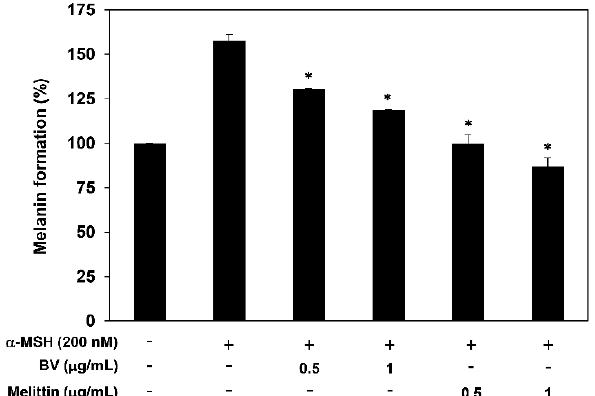
Figure 5. The effect of BV and melittin on the melanogenesis of α-MSH-stimulated B16F10 cells. Cells were treated with BV and melittin in the presence or absence of α-MSH for 72 h, and the cellular melanin contents were determined. * p < 0.05 versus the α-MSH control. Each value represents the mean ± SE from three independent experiments.